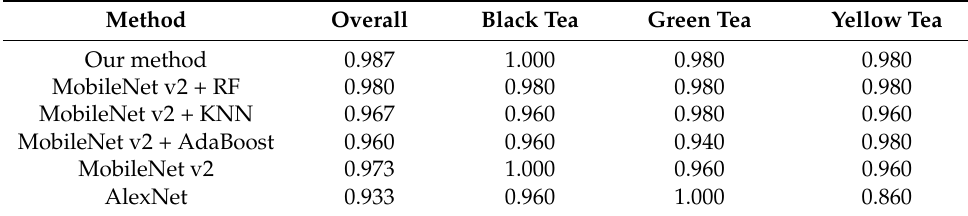
Table 6. Comparison of classification accuracy of different